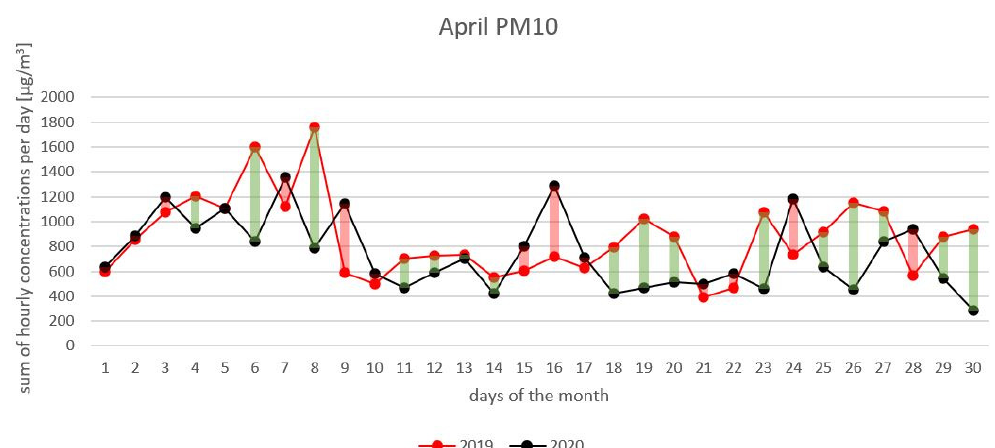
Figure 10. Concentrations of PM2.5 and PM10 recorded at the air quality monitoring station in Wawer district in March and April 2020. Red colour indicates increase and green colour indicates decrease in relation to 2019.